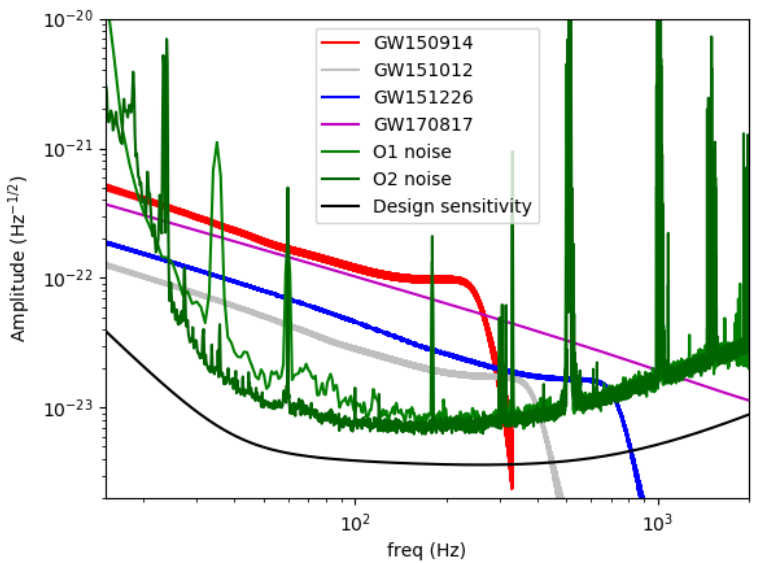
Figure 17. Spectrum of the 3 detected gravitational wave events in O1 and of GW170817 compared to the real O1 and O2 noise (of the LIGO Livingstone detector) and to the Advanced LIGO design sensitivity. Data from the LIGO Open Science Center